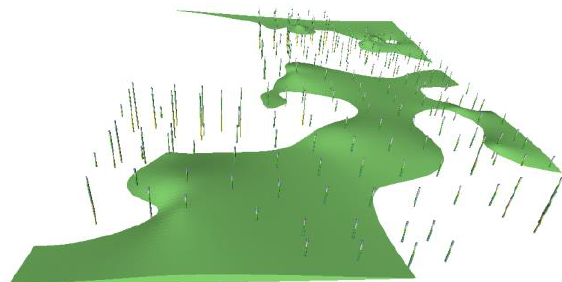
Figure 11. The pinch-out stratum model was simulated very naturally and